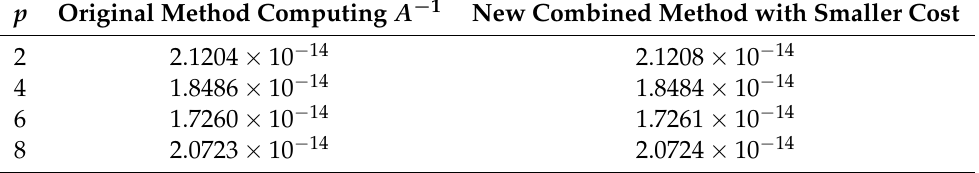
Table 2. Error for the approximation of A 1/ p taking m = 100, k = 2 × 10 − 6 , k / h 2 = 2 × 10 − 2 and three